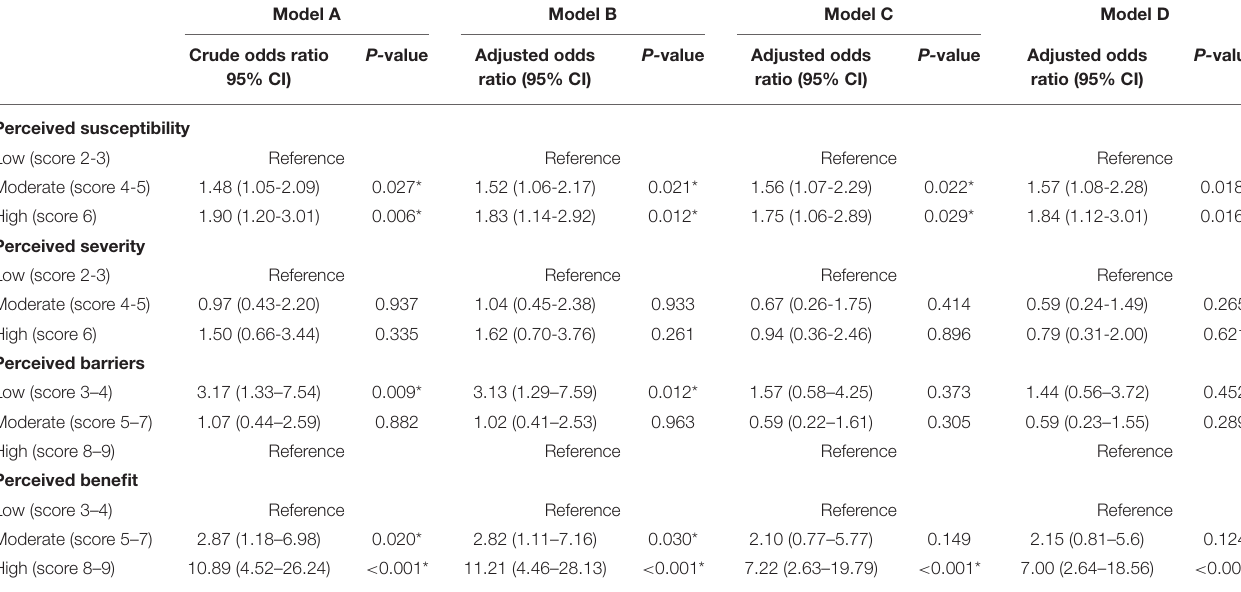
TABLE 3 | The association between risk perception and the acceptance of a booster dose of COVID-19 vaccine to children among 1,724 child caregivers in China. Model A Model